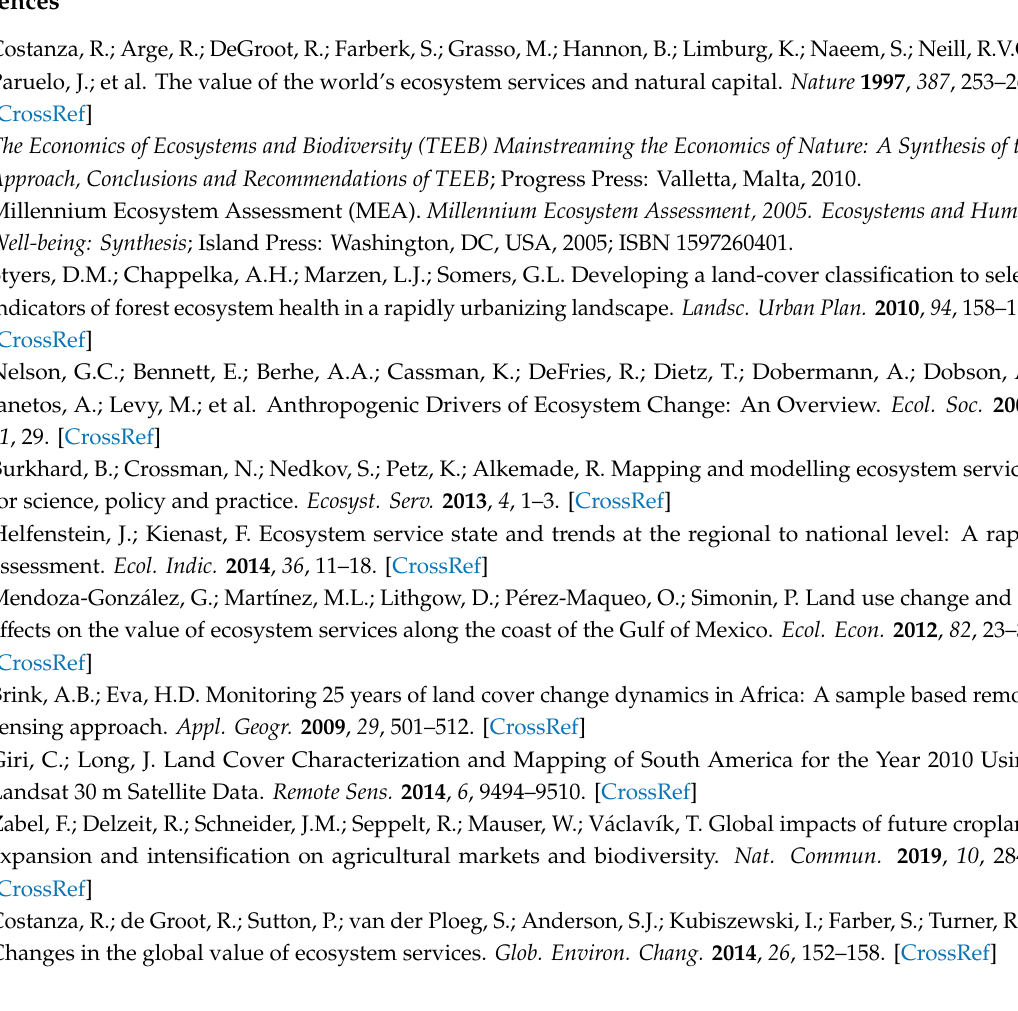
Table S1: E ff ect of LULC change on the total value of ecosystem services of ACB from 1985–2050 based on Kindu’s et al. (2016) local unit value coe ffi